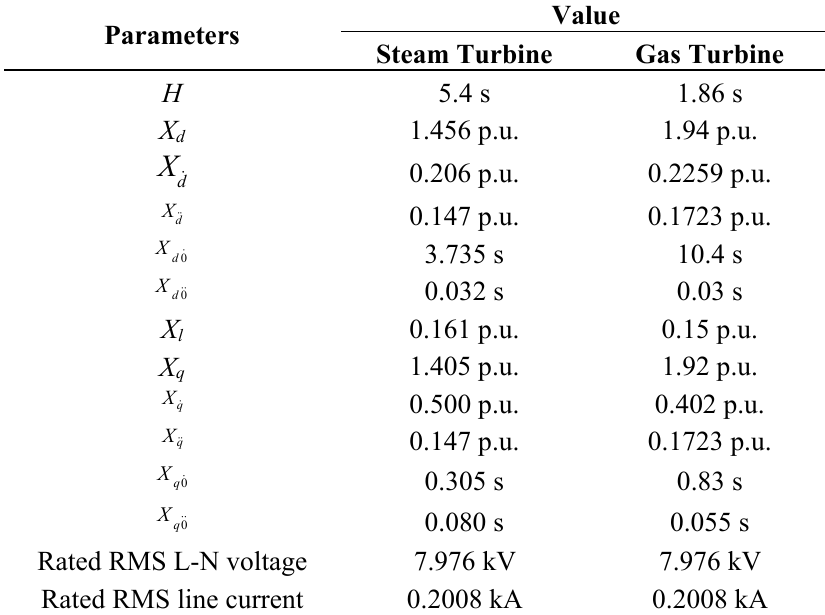
Table 2. Steam and gas turbine synchronous machine model